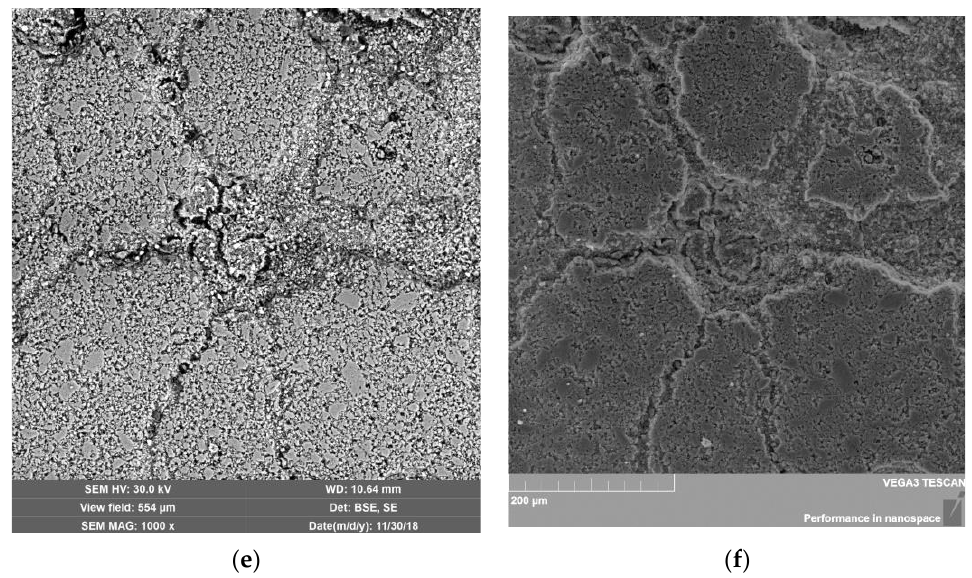
Figure 2. SEM BSE ( a , c , e ) and SE ( d , f ) images of as-sintered porous segmented ceramics. Scheme of the segmented structure with the indication of structural elements ( b ). Data for Sample #2 ( a ), Sample #1 ( c , d ), and Sample #4 ( e , f ) are shown.